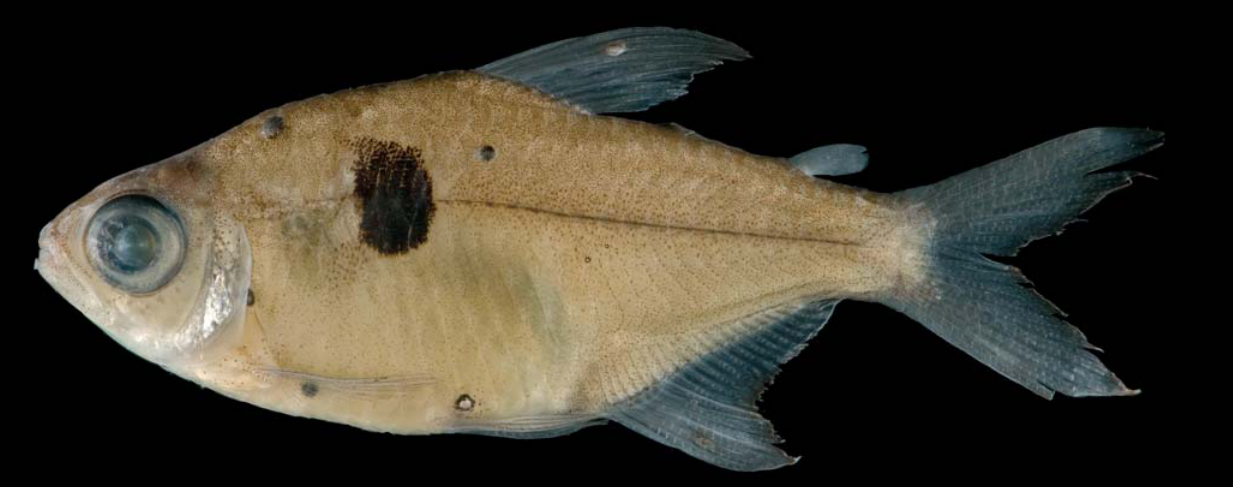
Fig. 1. Hemigrammus arua , holotype, MPEG 14755, 26.8 mm SL: Brazil, Pará State, município de Juruti, lago São Francisco do Alto Aruã. Black spots over body and fins are nematodes’